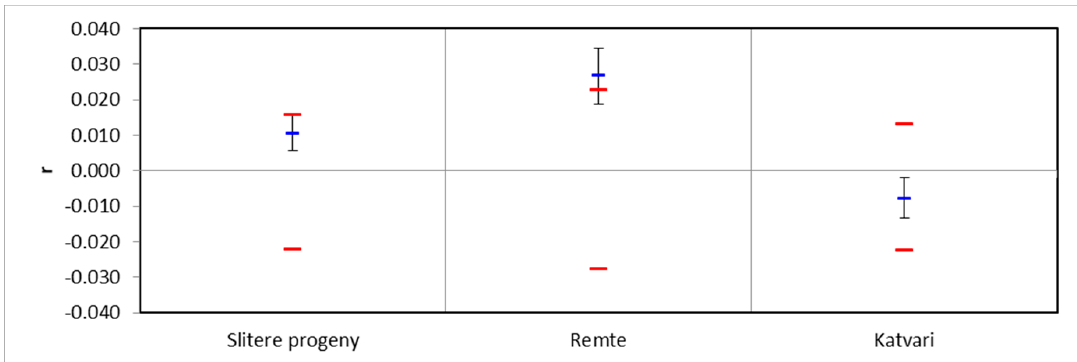
Figure 2. Average within population pairwise relatedness [29] values ( r ). Error bars indicate the 95% confidence interval of the mean values, as determined by resampling (999 bootstraps); red bars indicate the 95% confidence interval of the null hypothesis of “no difference” between the populations.